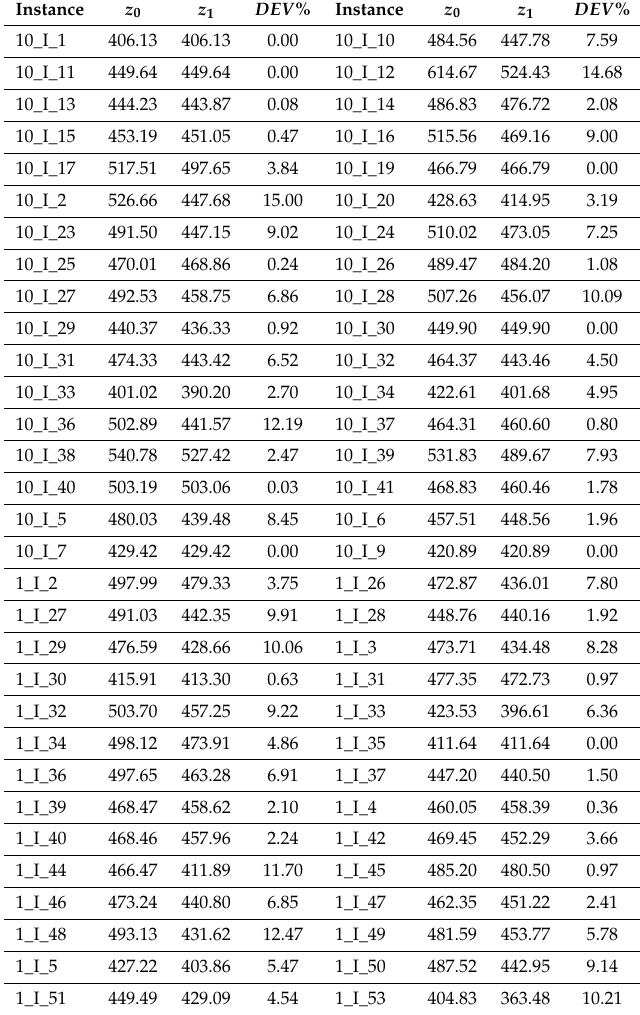
Table 5. Computational results for the London